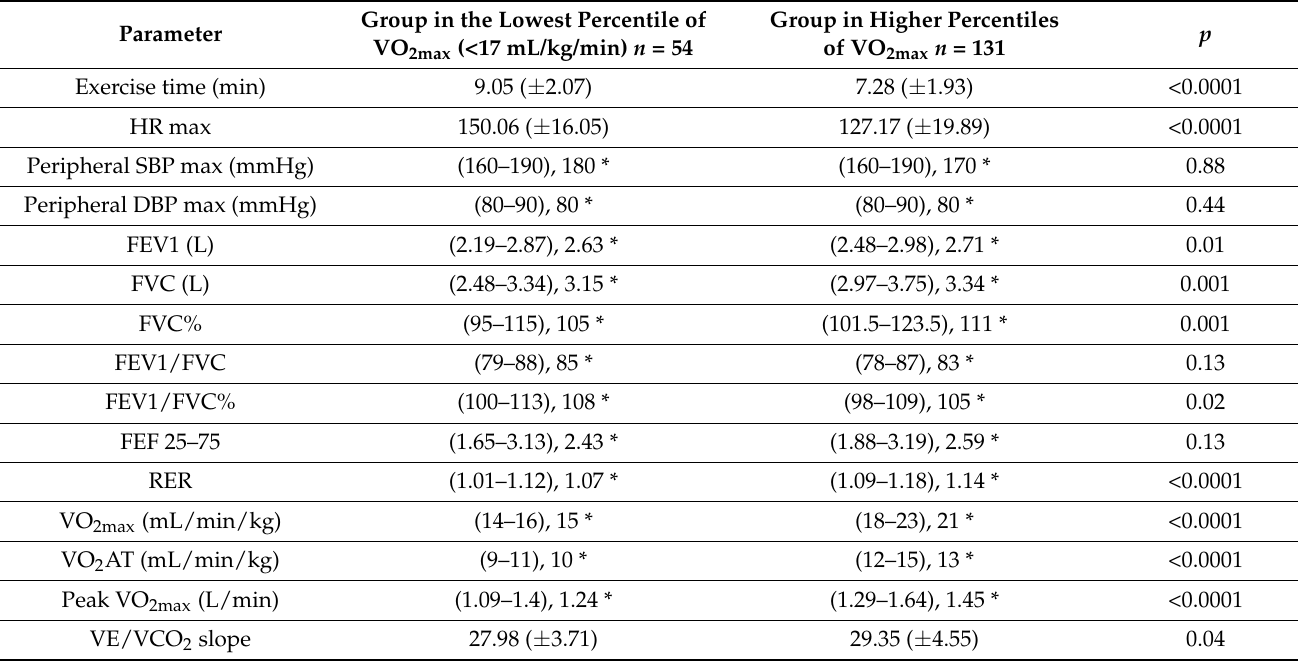
Table 3. Evaluation of spiroergometric